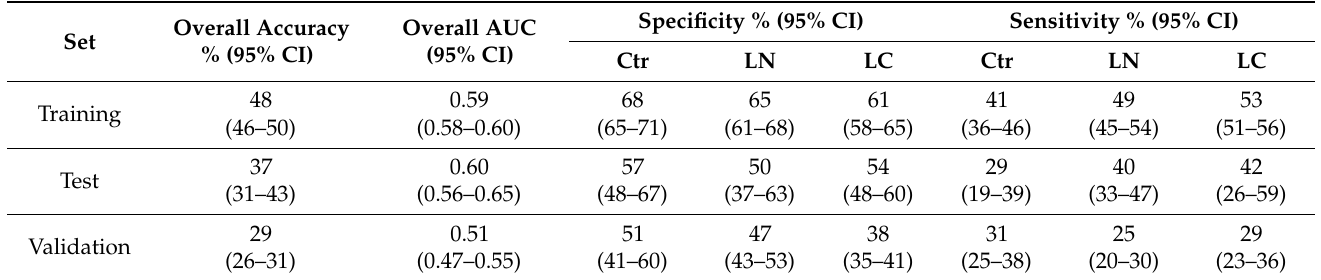
Table 2. Indices of the classification model (mean values and 95% confidence intervals;